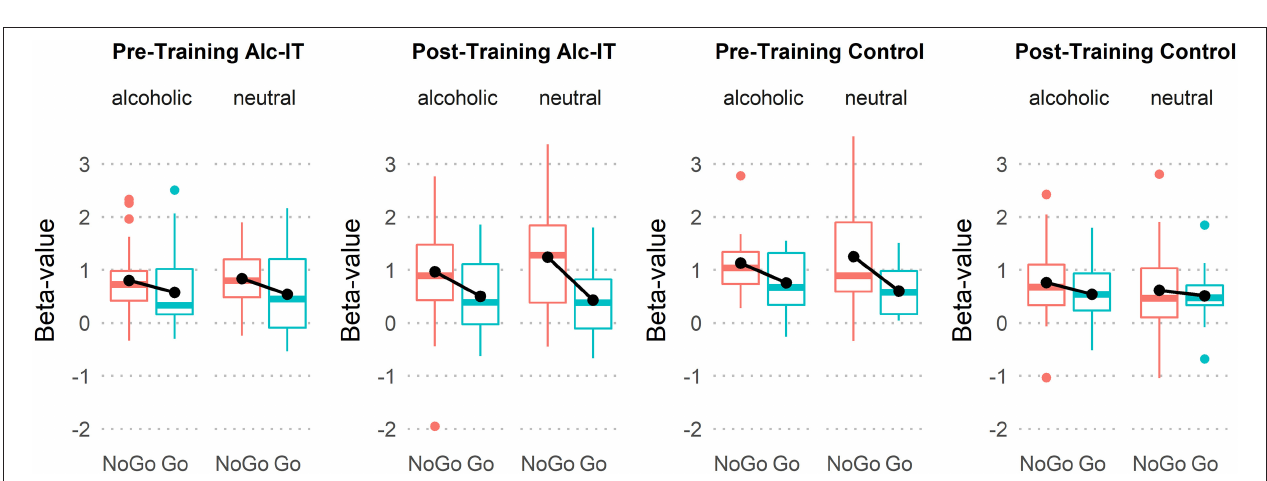
FIGURE 4 | Boxplots indicating beta-value differences of response type (NoGo in red, Go in green), stimulus type, pre- and post-training, and training type. Black lines connecting black dots highlight mean-differences in inhibition activation.